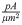
Ca2+ concentrations in the intracellular space, the internal Ca2+ store and the extracellular space, the IP3 concentration in the intracellular space and the ratio h of active IP3 receptor channels as a function of the maximal pump current of the Na+/Ca2+ exchanger (INCXmax) and the volume ratio between the internal Ca2+ store and the intracellular space (ratioER).The astrocytic compartment was stimulated for 200 seconds with a Poisson spike train of 100 Hz. The corresponding glutamate concentration in the extracellular compartment as a function of time was calculated using the Tsodyks and Markram model. Blue, gray and red lines denote the dynamics of [IP3]i, h [Ca2+]i, [Ca2+]ER, [Ca2+]o for values of INCXmax equal to 0 pAμm2, 0.001 pAμm2 and 1 pAμm2. a Analysis of the GluT-dependent pathway in isolation. [Ca2+]i is shown as a function of ratioER and for different values of INCXmax. b-f Analysis of both the mGluR- and the GluT-dependent pathway. [IP3]i, h, [Ca2+]i, [Ca2+]ER and [Ca2+]o are shown as a function of ratioER and for different values of INCXmax.